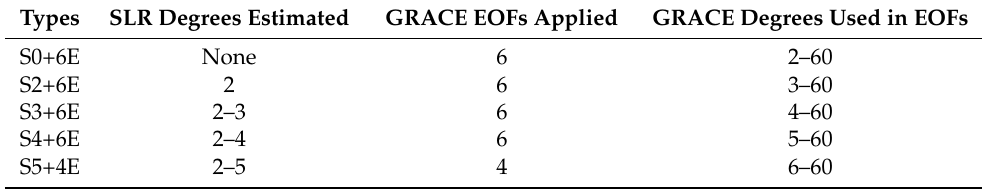
Table 2. Solution types of the IGG data [16].